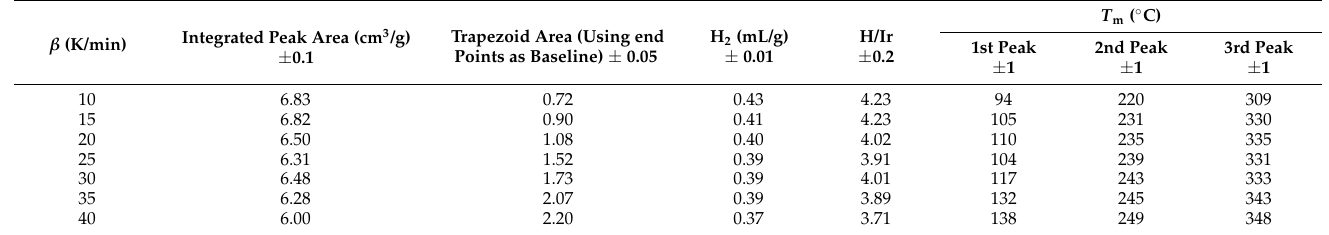
Table 2. TPR data analysis of 3.5 wt.% IrO 2 -TiO 2 (anatase, BET = 55 m 2 /g) with variable ramping rates β